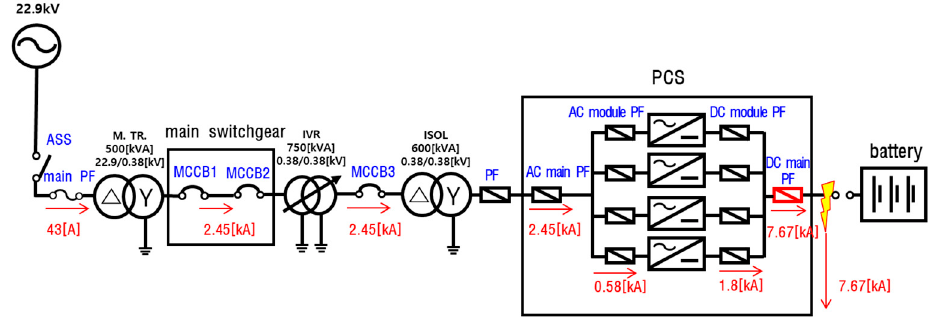
Figure 14. Maximum current passing through protection devices during DC fault.